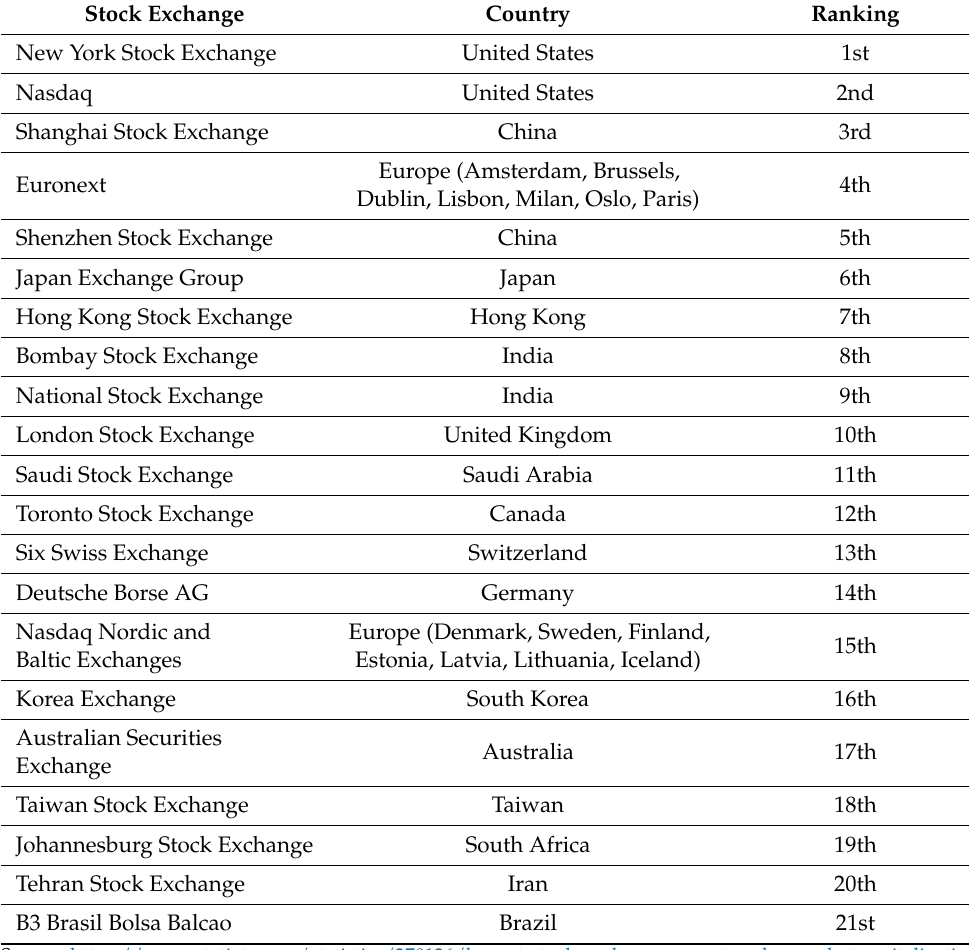
Table 1. World Major Stock Exchanges Ranked by Market Capitalization. Stock